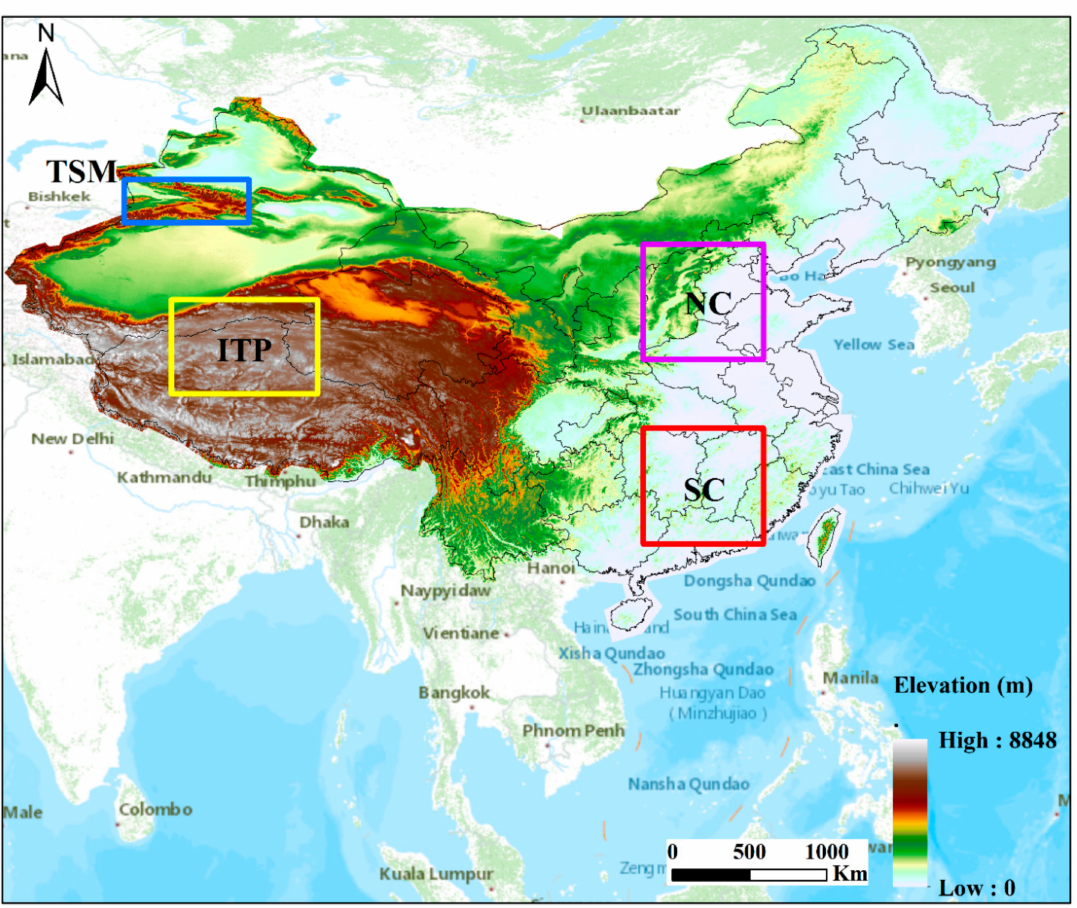
Figure 1. Schematic map of elevation in China. Four hotspots are marked, namely North China (NC), South China (SC), Tianshan Mountain (TSM), and the Interior of the Tibetan Plateau